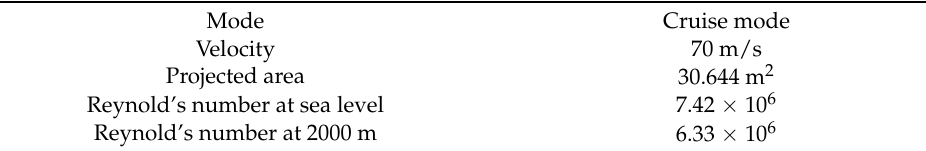
Table 14. Boundary conditions for drag calculations.